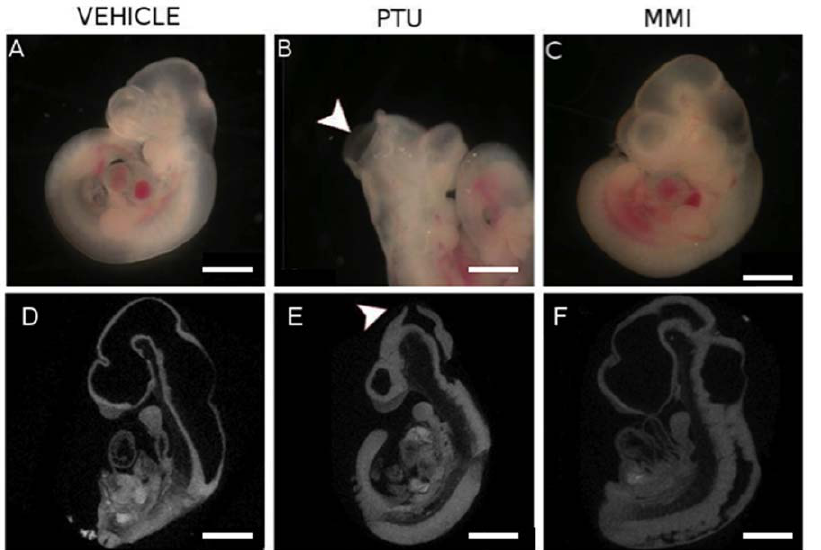
Figure 1. PTU exposure during embryogenesis induces cranial defects. Representative images of E10.5 embryos treated with (A, D) vehicle, (B, E) PTU (100 mg/kg) or (C, F) MMI (20 mg/kg) illustrate un-fused cephalic neural folds in PTU-treated embryos (arrowhead). (D–F) MicroCT scans showing sagittal 3D images of E10.5 whole embryos with arrowhead identifying unfused neural folds defect. Scale bars=0.5 mm. doi:10.1371/journal.pone.0035213.g001 PLoS ONE |